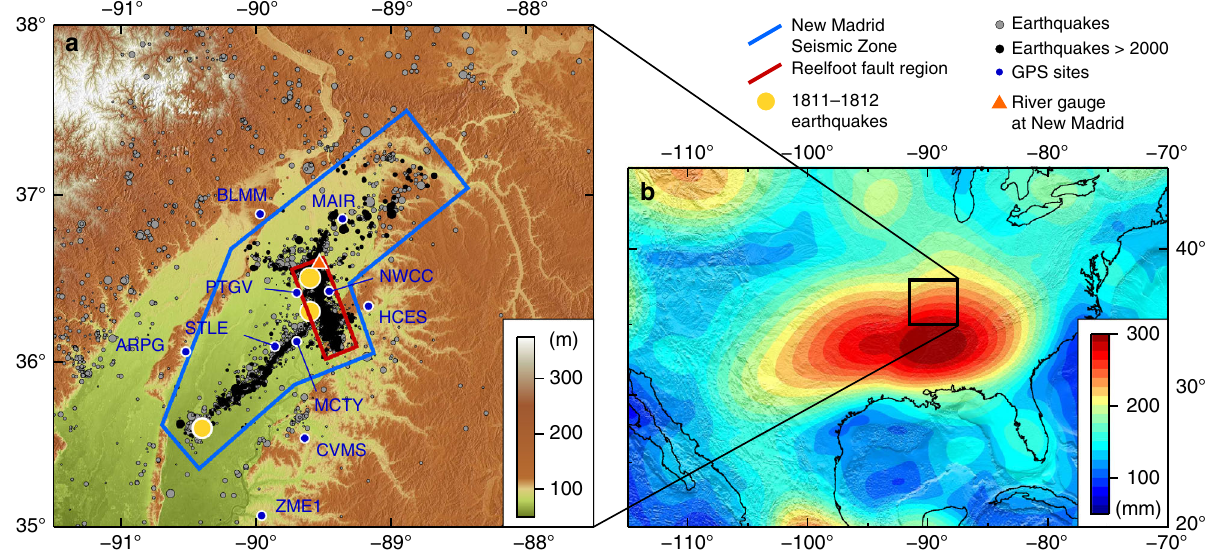
Fig. 1 The New Madrid Seismic Zone (NMSZ). a Seismicity in the NMSZ from the full CERI catalogue 27 (grey points), highlighting those since 1 January 2000 (black points). Yellow circles are the approximate locations of the 1811 – 1812 earthquakes. Earthquakes are scaled by magnitude. Blue and red boxes outline the approximate areas of the NMSZ and the Reelfoot fault, respectively. Other symbols indicate the river gauge at New Madrid (orange triangle), and continuously operating GPS sites in proximity to the NMSZ (blue circles). b Peak-to-peak variation in annual surface load from satellite gravity data, expressed as equivalent water height in